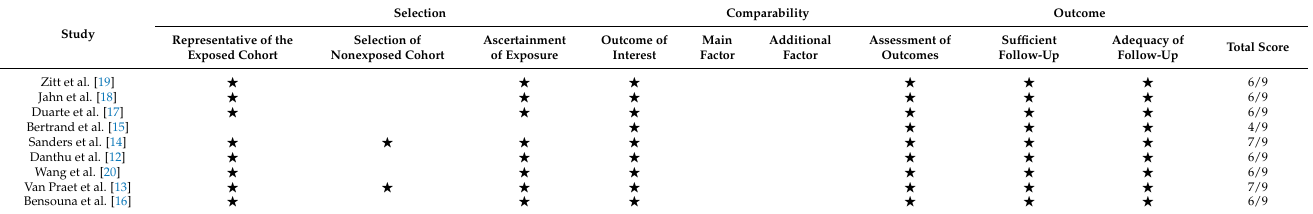
Table 4. Methodological quality (Newcastle-Ottawa Scale—NOS) of studies included in the